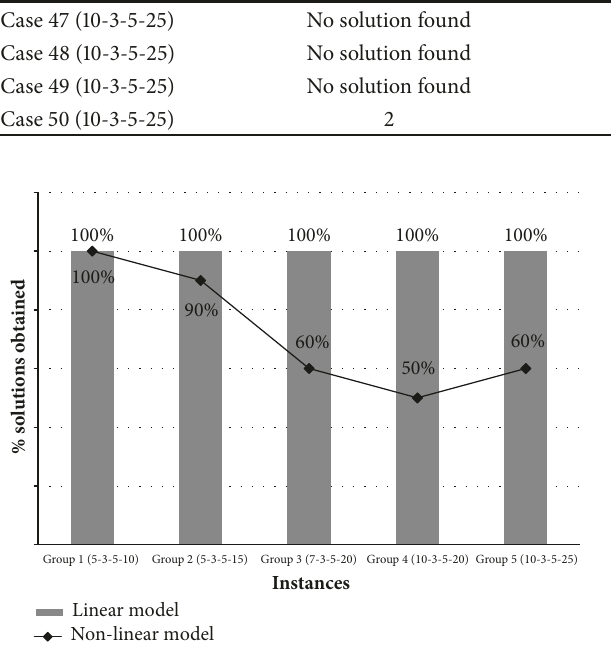
Figure5:Percentofsolutionsobtained,comparingnonlinearversus linear